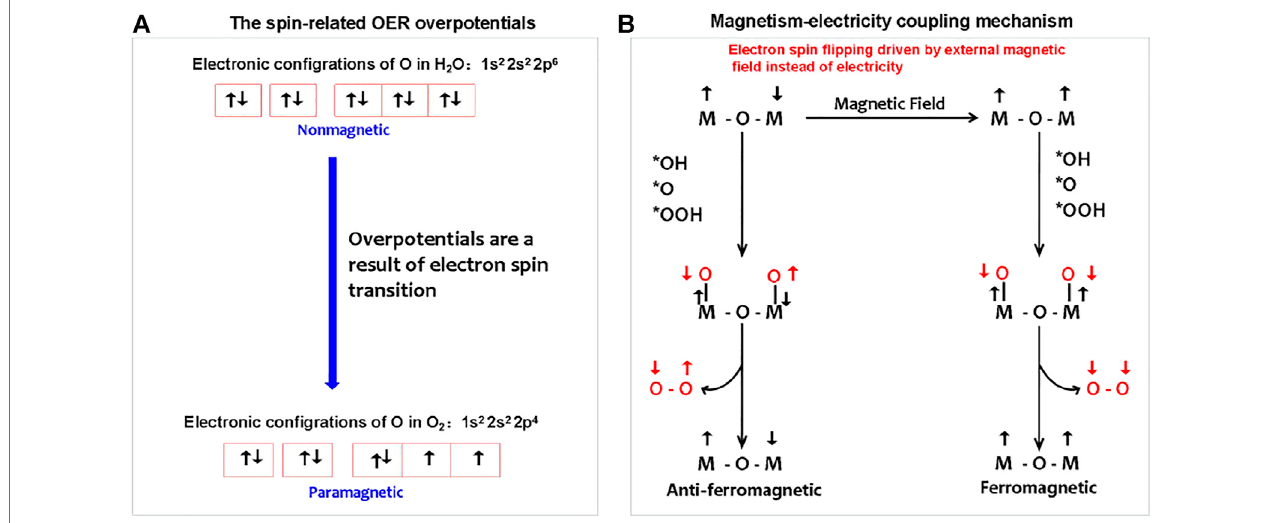
FIGURE 4 | (A) Spin-related OER overpotentials from electron spin changes during nonmagnetic water splitting to paramagnetic O 2 . (B) Magnetism – electricity coupling water splitting follows the mechanism of magnetic fi eld, instead of electricity-driven spin ordering. The magnetic fi eld-driven magnetic transition from anti- ferromagnetic to ferromagnetic is adopted as an example to describe the magnetism – electricity coupling